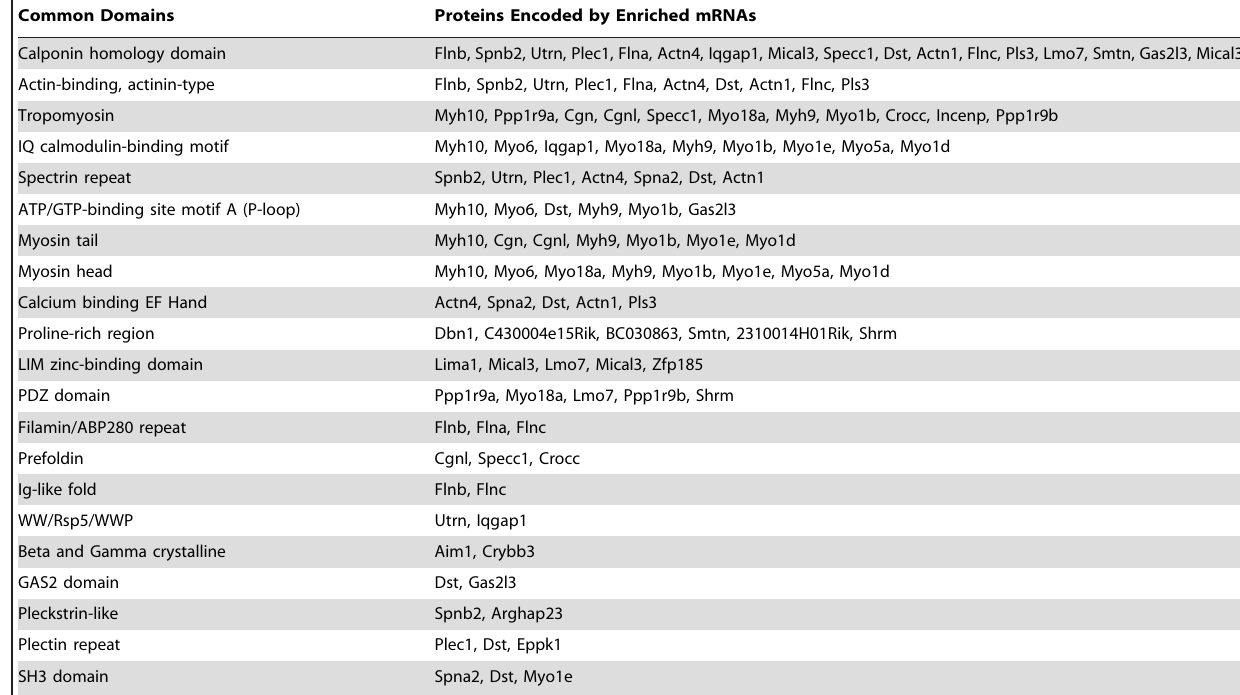
Table 3. Protein domains enriched in products of identified